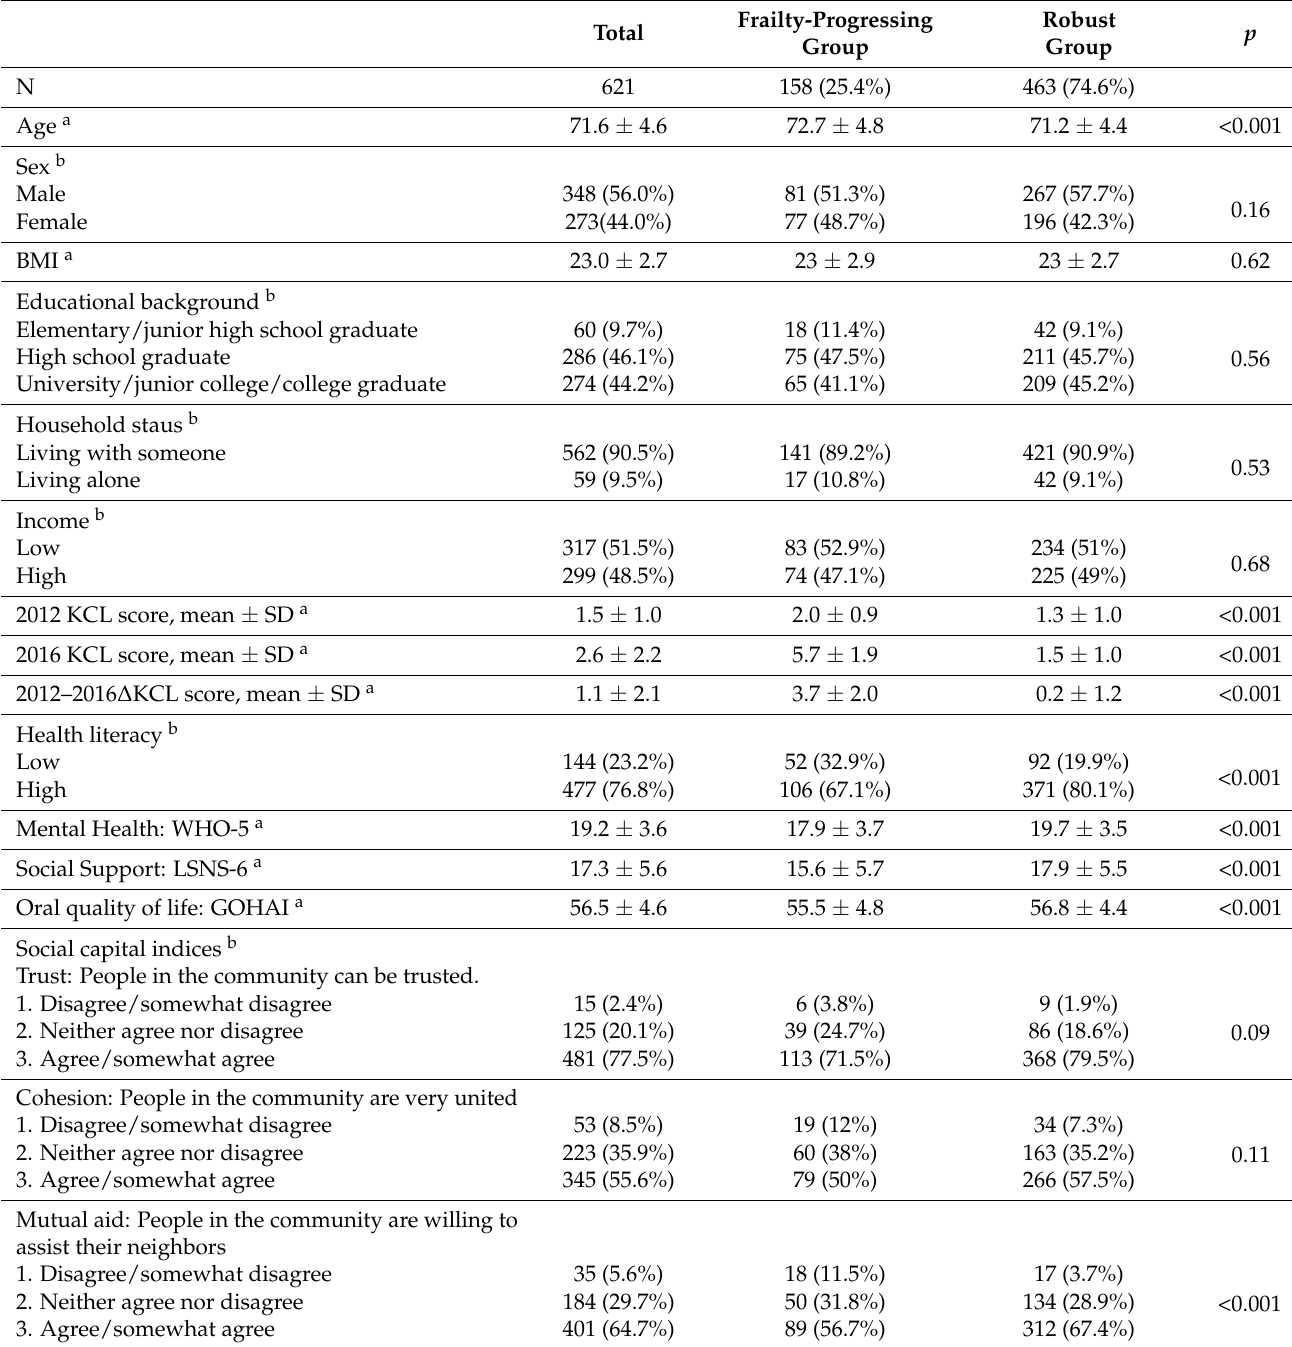
Table 1. Comparison between the frailty-progressing group and robust